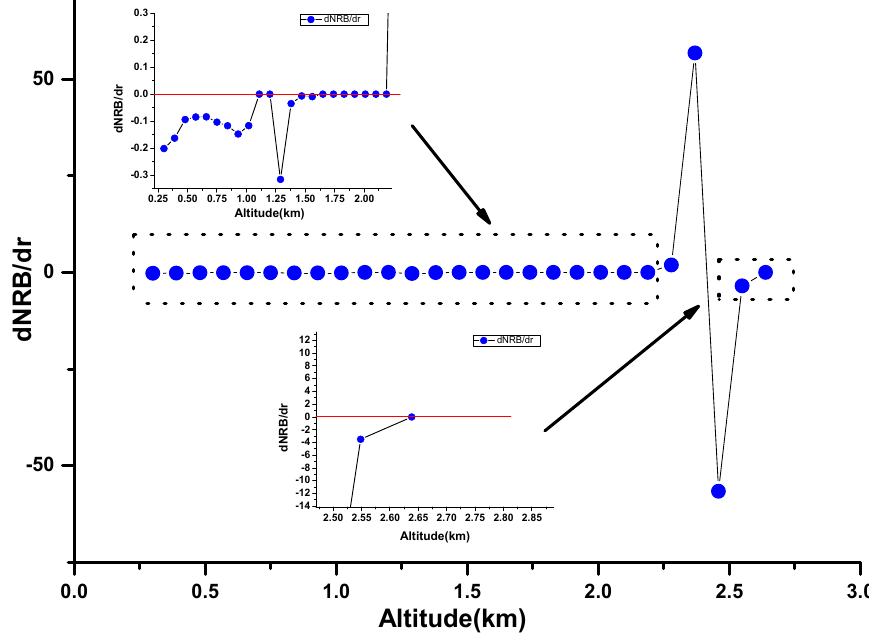
Figure 3. The gradient of NRB processed by interval thresholding technique.